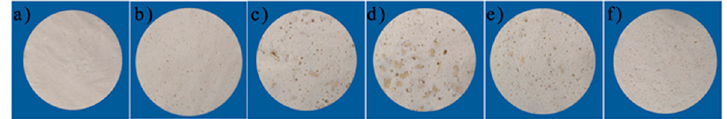
Figure 2. The synthesis process of TOPUFL. Table 2. Foam formulation and design.